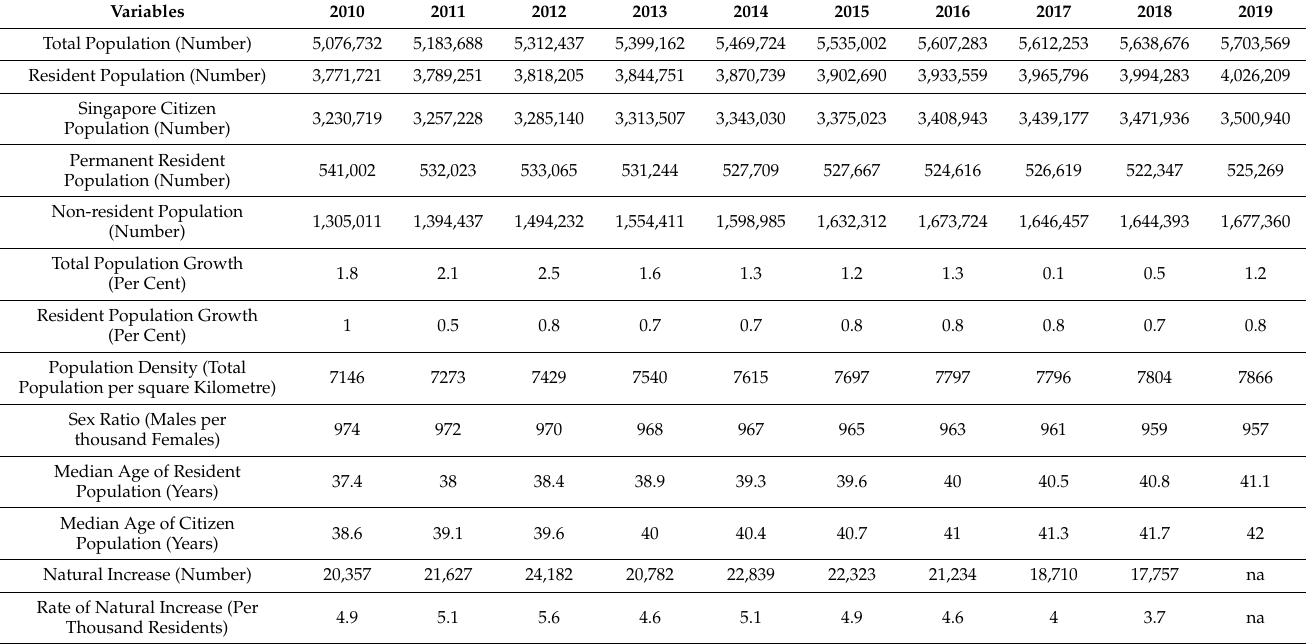
Table 1. Population figures of Singapore: 2010 to